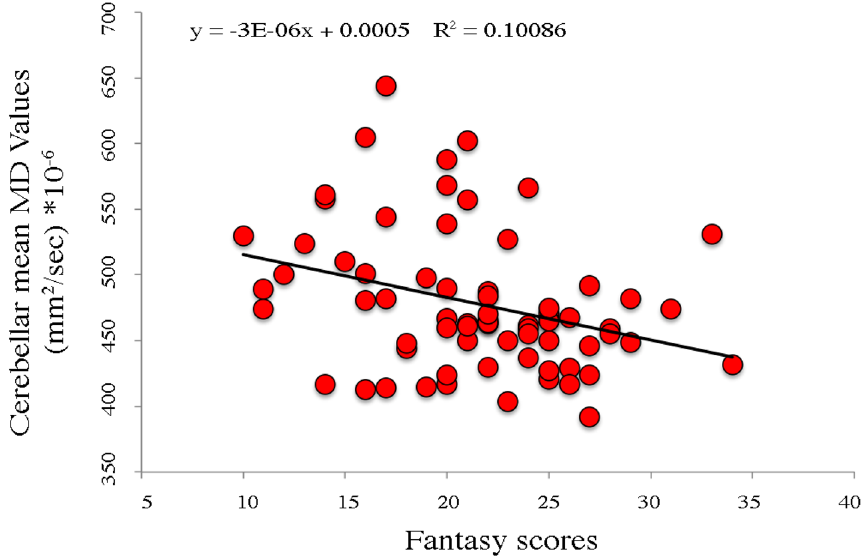
Figure 2. Negative association between cerebellar Crus 2 mean Mean Diffusivity (MD) values and Fantasy IRI subscale scores. Equation, R 2 and linear fit (solid black line) are